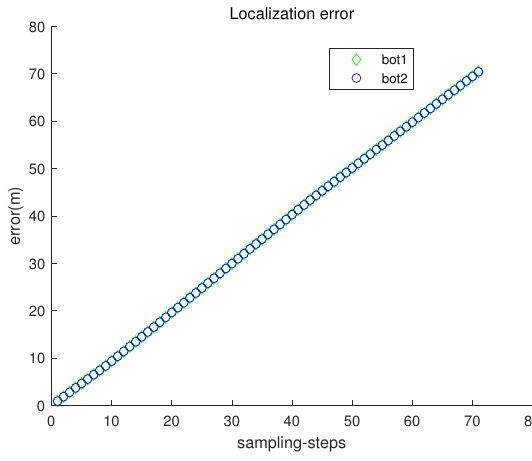
Figure 8. The localization error (cid:107) r i ( k ) − ˆ r i ( k ) (cid:107) with respect to sampling-stamp k (dead reckoning strategy in Scenario